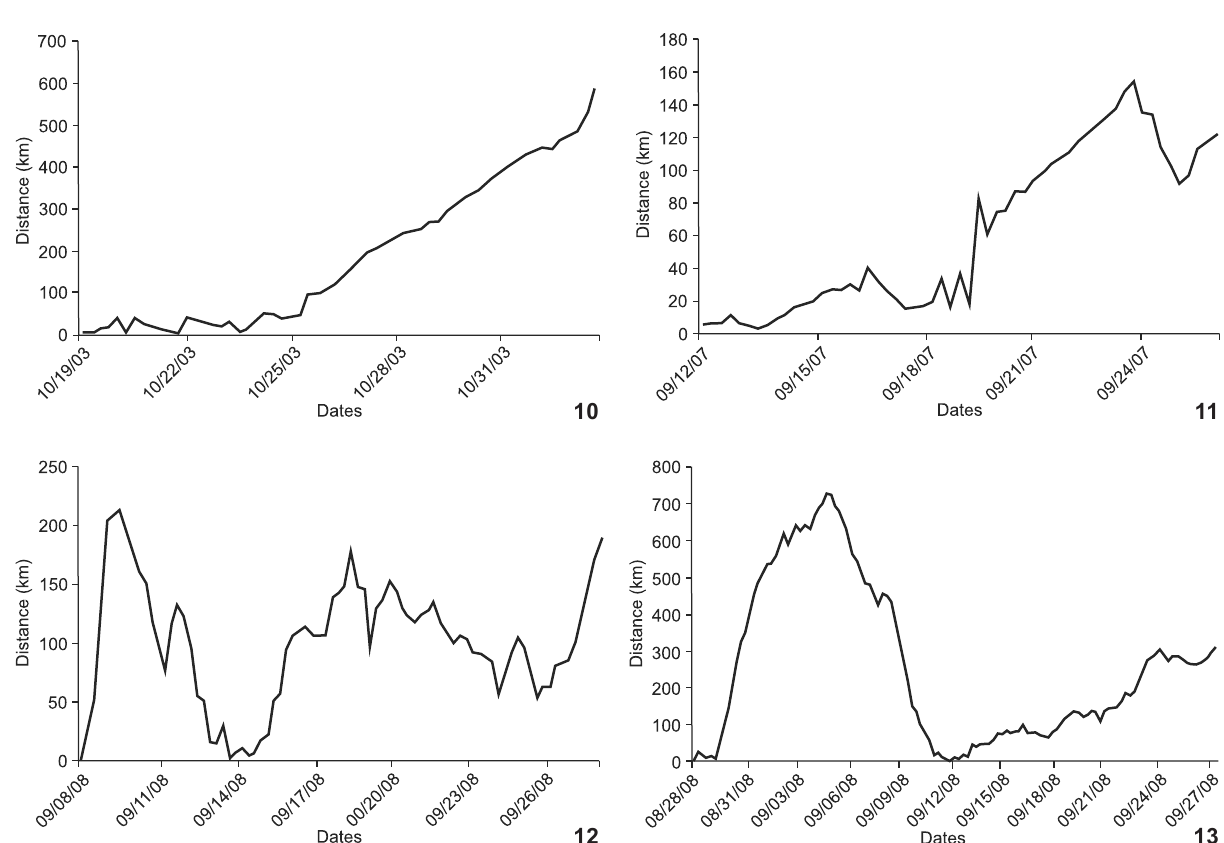
Figures 10-13. Calculated distance between the individuals humpback whales belonging to the same pair: (10) Pair A; (11) Pair B; (12) Pair C; (13) Pair